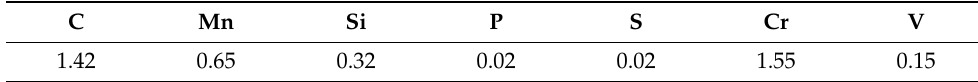
Table 1. Chemical composition of steel used